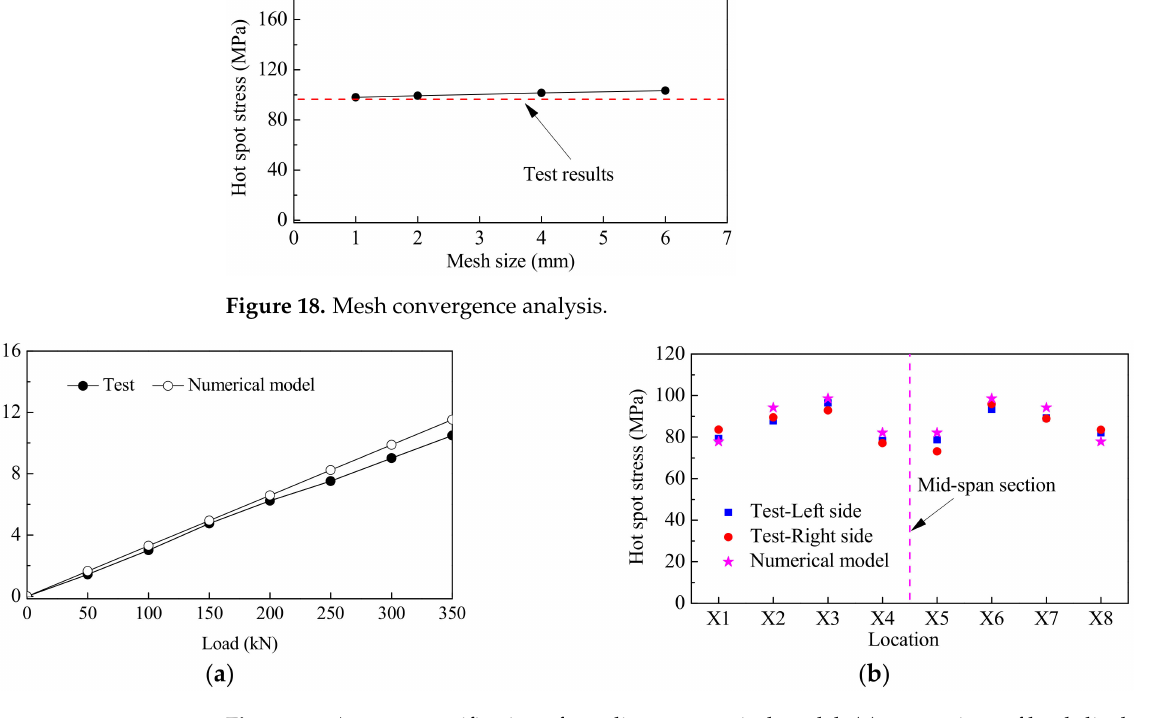
Figure 19. Accuracy verification of non-linear numerical model: ( a ) comparison of load-displacement curves; and ( b ) comparison of hot-spot stress